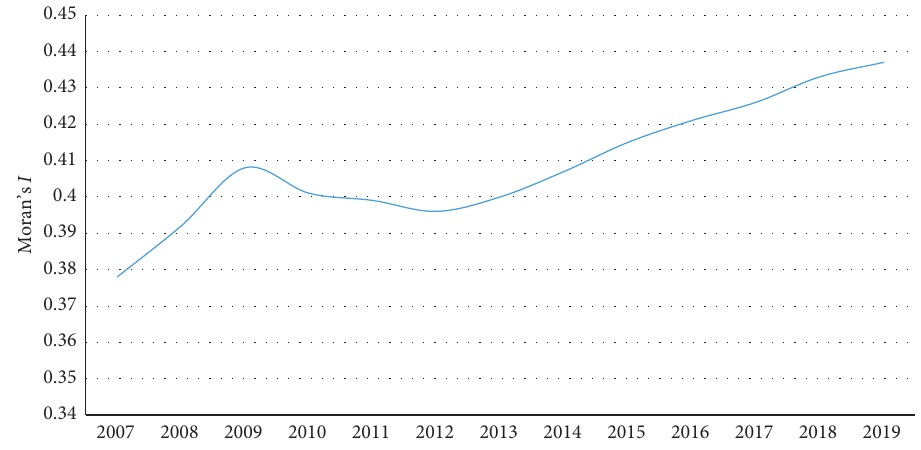
Figure 1: Trend of the global Moran’s index.